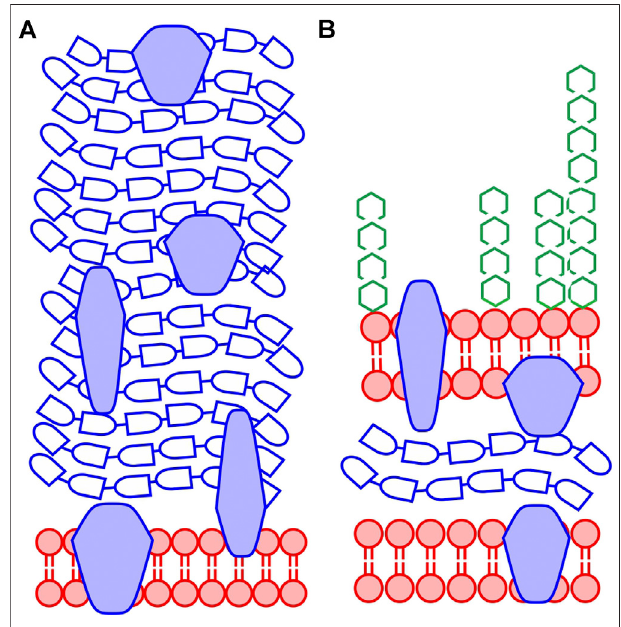
FIGURE 1 | Generalized schematic structure of the cell envelope for bacteria. (A) Gram-positive bacteria have a thick peptidoglycan layer covering the plasma membrane (B) Gram-negative bacteria have a cell envelope consistingofaninnerplasmamembrane,athinpeptidoglycanlayer,and an asymmetric outer membrane consisting of lipids and lipopolysaccharides. Throughout the cell envelope, there are proteins with various functions for both types of bacteria. The color coding of the fi gure relates to the substance groups discussed in this work: lipid-like substances (red), peptide containing substances, i.e., protein and peptidoglycan (blue) and polysaccharides (green). Proteins and other structures may be glycosylated and in the Gram- positivecellenvelopethereareteichoicacidsandlipoteichoicacidscontaining polysaccharide-like structures (not shown in the fi gure). The Pseudomonas fl uorescens bacteria analyzed here are